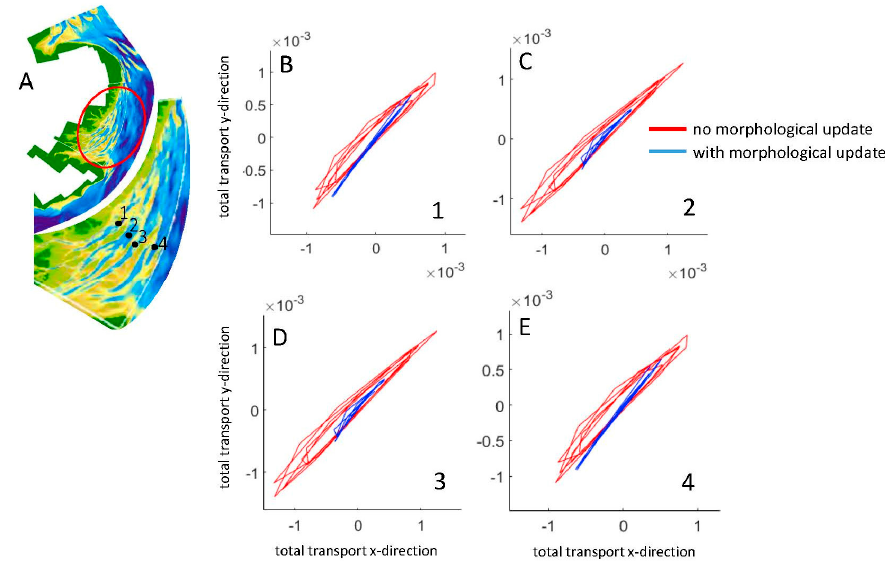
Figure 7. ( B – E ) Orbital plots of sediment transport (m 3 /s/m) vectors for points indicated in panel A .